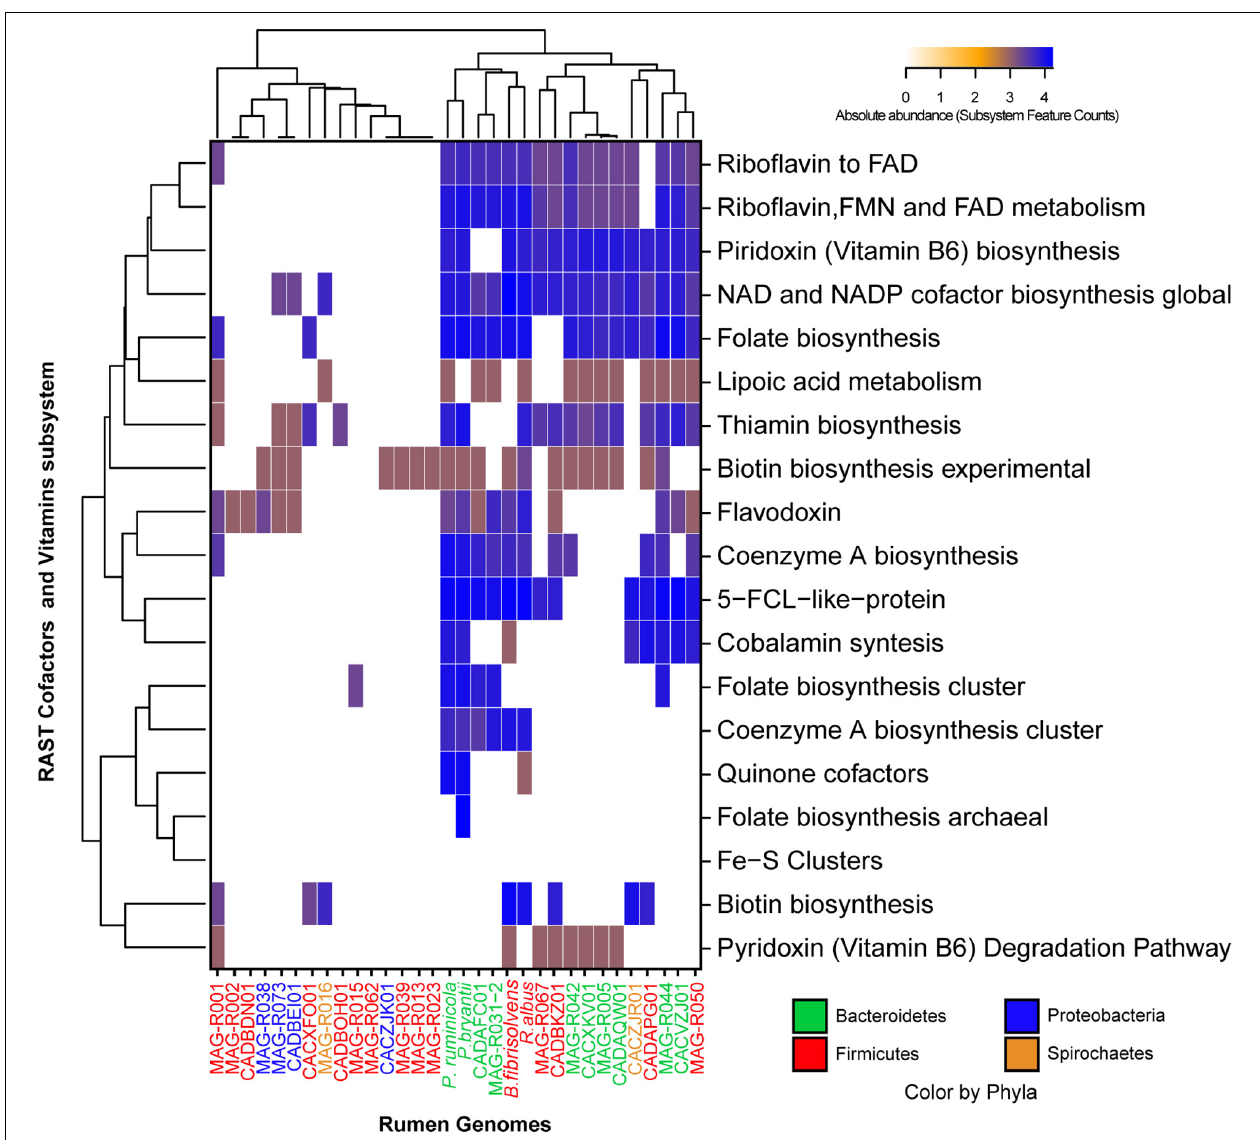
FIGURE 5 | Absolute abundance of the subsystem feature counts found in the vitamins and co-factors category established by RAST (rapid annotation using subsystem technology) for each of the representative